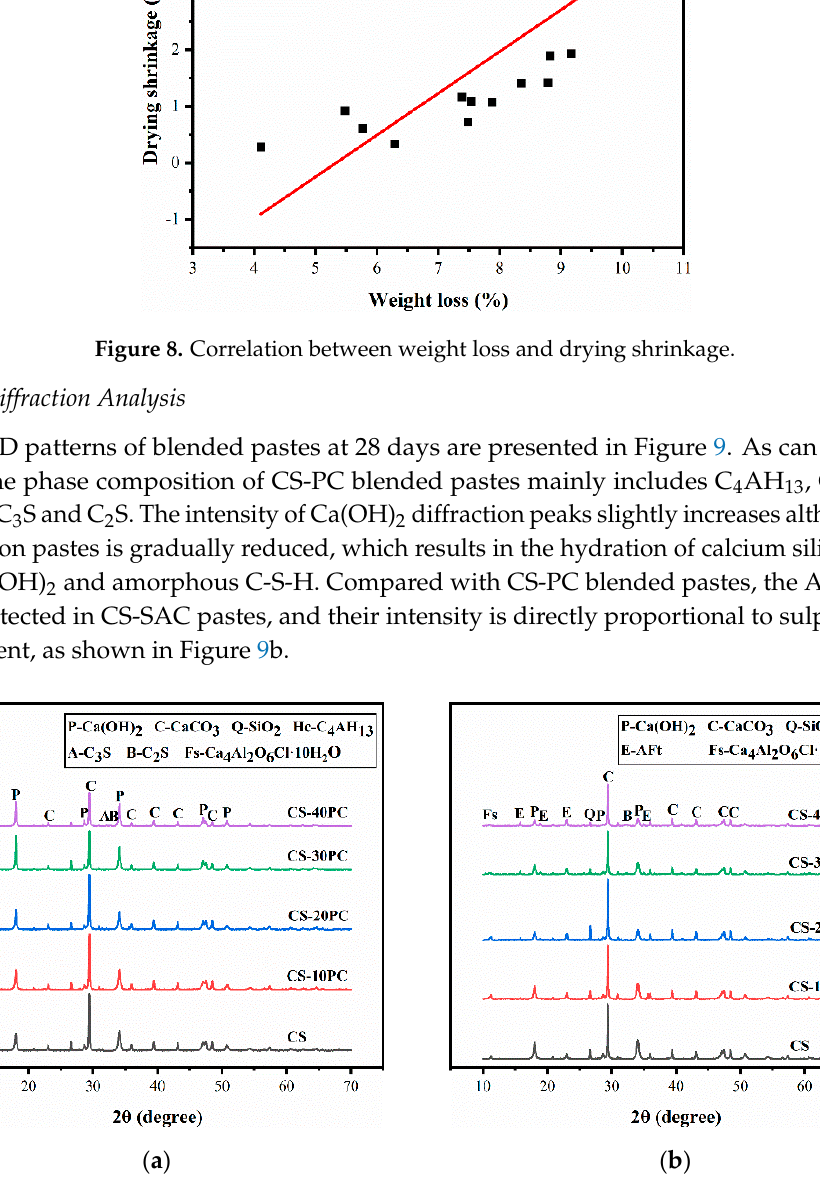
Figure 9. XRD patterns of blended pastes at 28 days: ( a ) CS-PC blended pastes; ( b ) CS-SAC blended pastes.